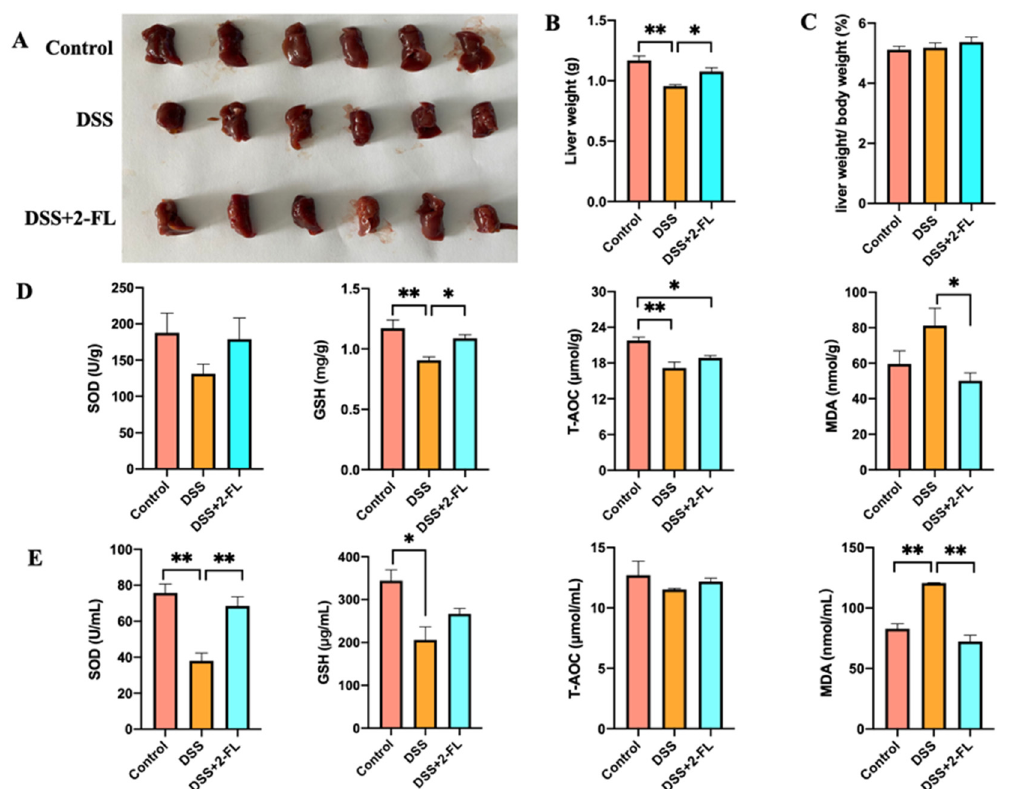
Figure 1. 2 ′ -FL alleviated colitis-induced oxidative damages in the liver. ( A ) The liver of individual mice in three groups. ( B ) Liver weight. ( C ) The ratio of liver weight to body weight. ( D ) The levels of Glutathione (GSH), malondialdehyde (MDA), total antioxidant capacity (T-AOC) and superoxide dismutase (SOD) in the liver ( n = 6). ( E ) The levels of T-AOC, GSH, MDA, and SOD in serum ( n = 4). Significance determined using one-way ANOVA and expressed as mean ± SEM. *, p < 0.05. **, p < 0.01.